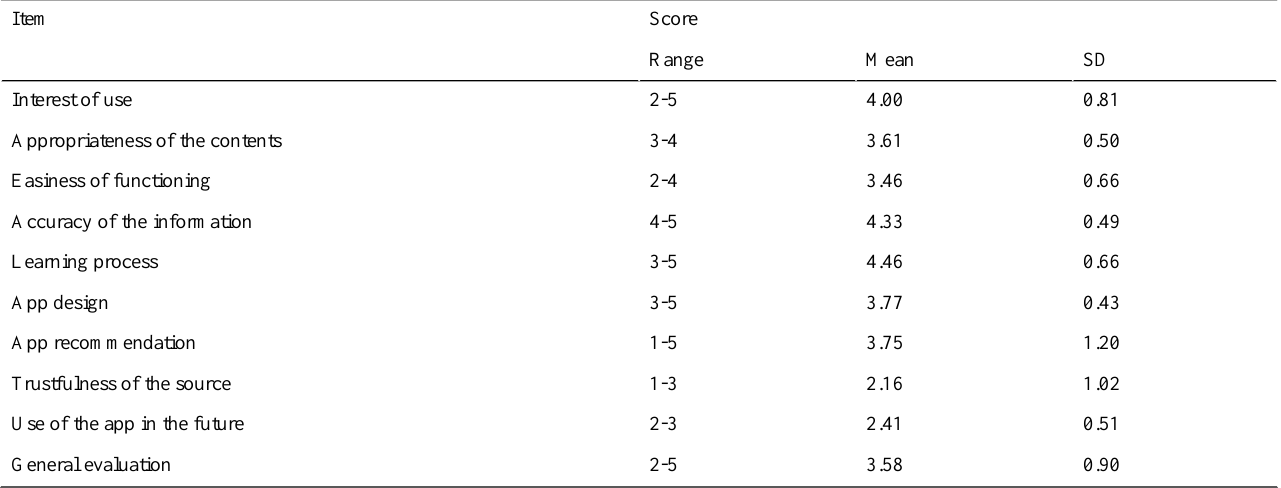
Table 2. Descriptive statistics of the Mobile App Rating